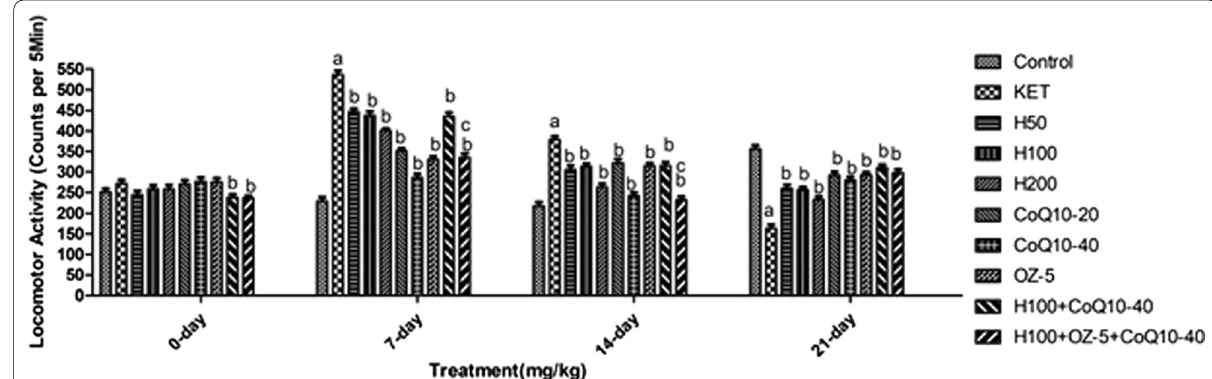
Fig. 1 Effect of Hesperidin, Coenzyme Q10, Olanzapine and their combinations on ketamine-induced locomotor dysfunction. Data were analyzed by two-way ANOVA followed by the Bonferroni test. All values were expressed as Mean compared to ketamine, c p < 0.05 as compared to Hesperidin (100 mg/kg). KET, Ketamine; H, Hesperidin; CoQ10, Coenzyme Q10; OZ,